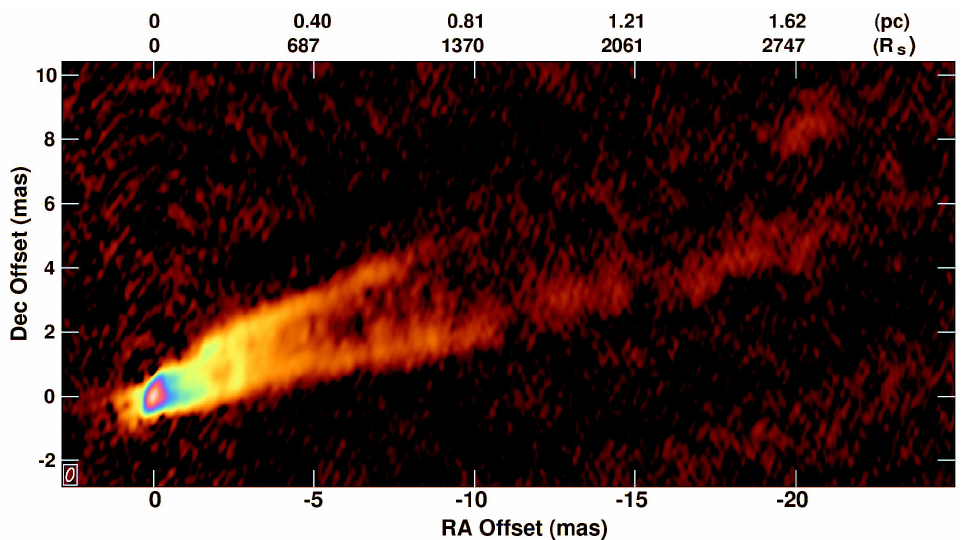
Figure 1. An image of M87 made with the Very Long Baseline Array (VLBA) at a frequency of 43 GHz based on data taken on 12 January 2013 using the upgraded VLBA at a recording bit rate of 2 Gbps. The axes are in mas from the brightest feature. Above, the axis ticks are labeled in parsecs and in Schwarzschild radii. The convolving beam is 0.43 × 0.21 mas elongated along position angle − 16 ◦